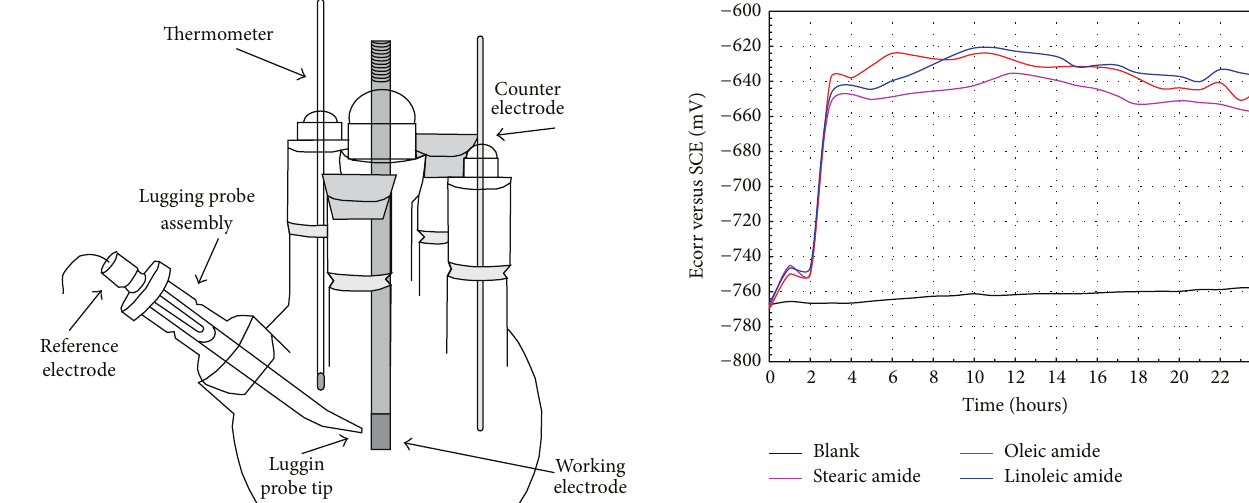
The electrochemical cell used was that described by standard ASTM G5 and shown in Figure 2. For LPR measurements, a sweep from − 20 to +20 mV versus open-circuit potential at a sweep rate of 1.0 mVs −1 was used and the polarization resistance ( 𝑅 𝑝 ) was measured from the slope of potential- current curve in the vicinity of corrosion potential ( 𝐸